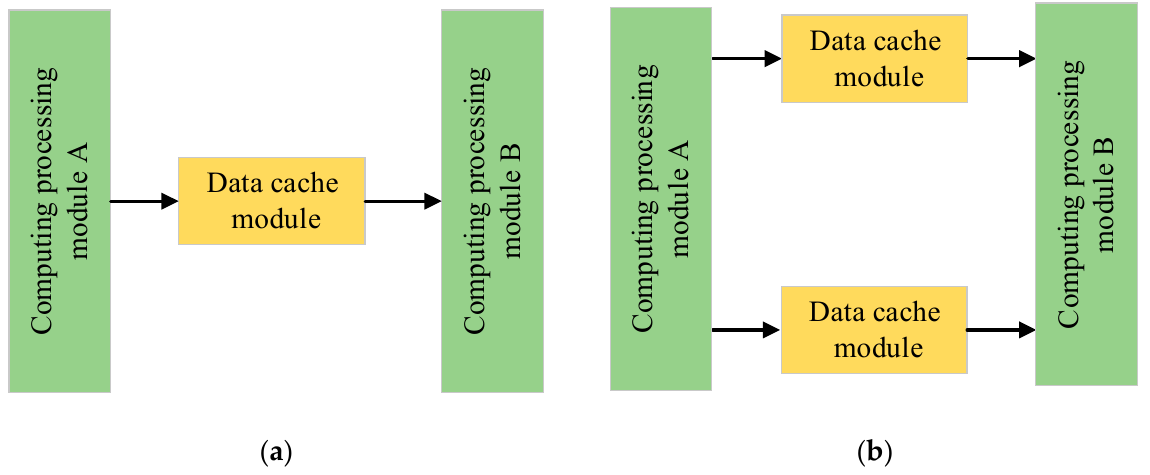
Figure 4. Data processing ( a ) without ping-pong operation and ( b ) with ping-pong operation.